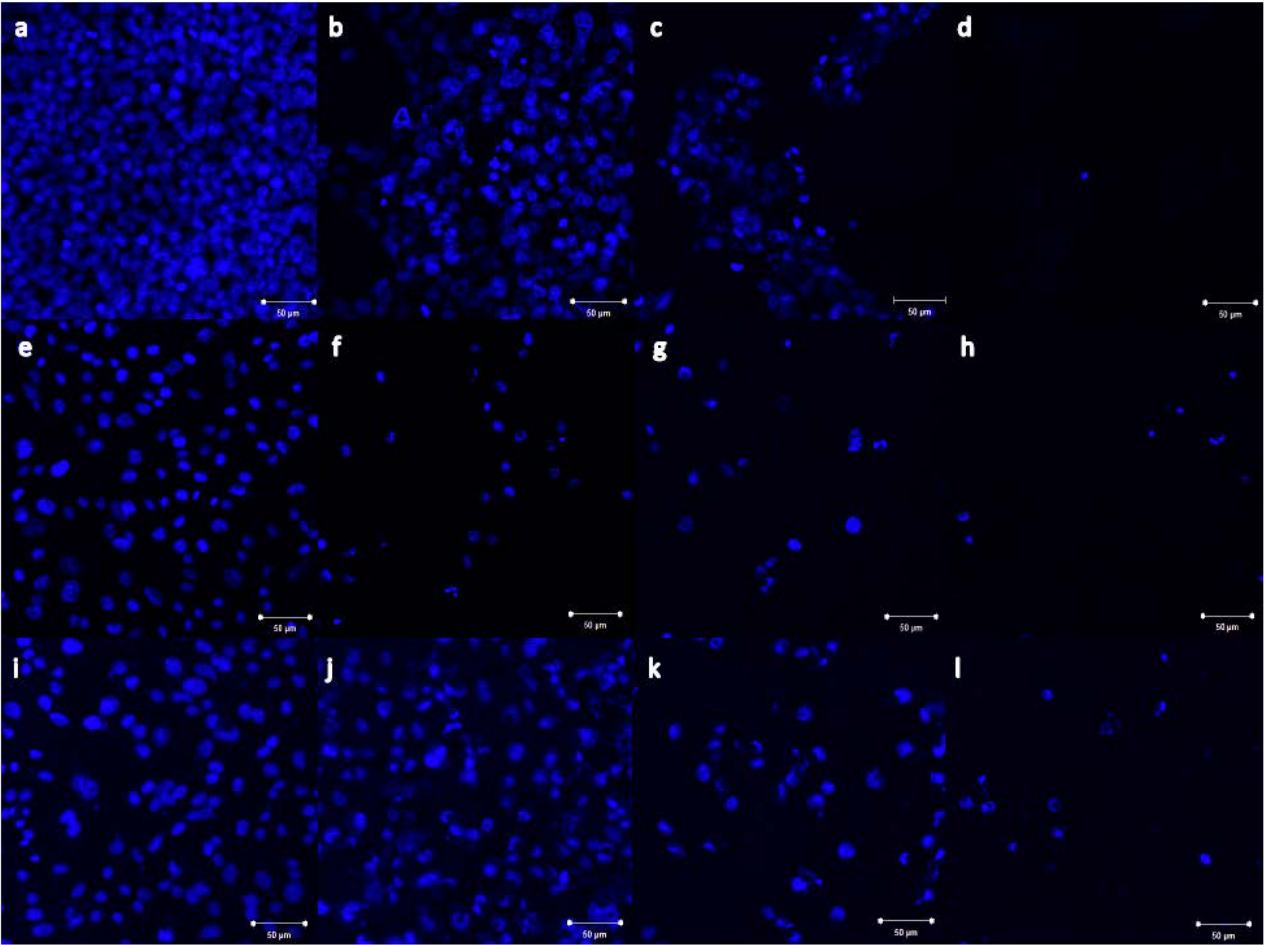
Figure 11. Confocal microscopic images of MCF-7, HCT116 and HeLa cells treated with β -Nb 2 ZnO 6 nanoparticles ( B ). The cells were treated for 48 h with 0.25, 0.5 and 1 mg/mL of β -Nb 2 ZnO 6 ( B ) nanoparticles. ( a ) Untreated MCF-7 cells, ( b – d ) MCF-7 cells treated with 0.25, 0.5 and 1 mg/mL of β -Nb 2 ZnO 6 ( B ), respectively. ( e ) Untreated HCT116 cell, ( f – h ) HCT116 cells treated with 0.25, 0.5 and 1 mg/mL of β -Nb 2 ZnO 6 ( B ), respectively. ( i ) Untreated HeLa cells, ( j – l ) HeLa cells treated with 0.25, 0.5 and 1 mg/mL of β -Nb 2 ZnO 6 ( B ), respectively. The blue tint signifies DAPI-stained cell nuclei (200x magnification, scale bar is 50 µm for all images).